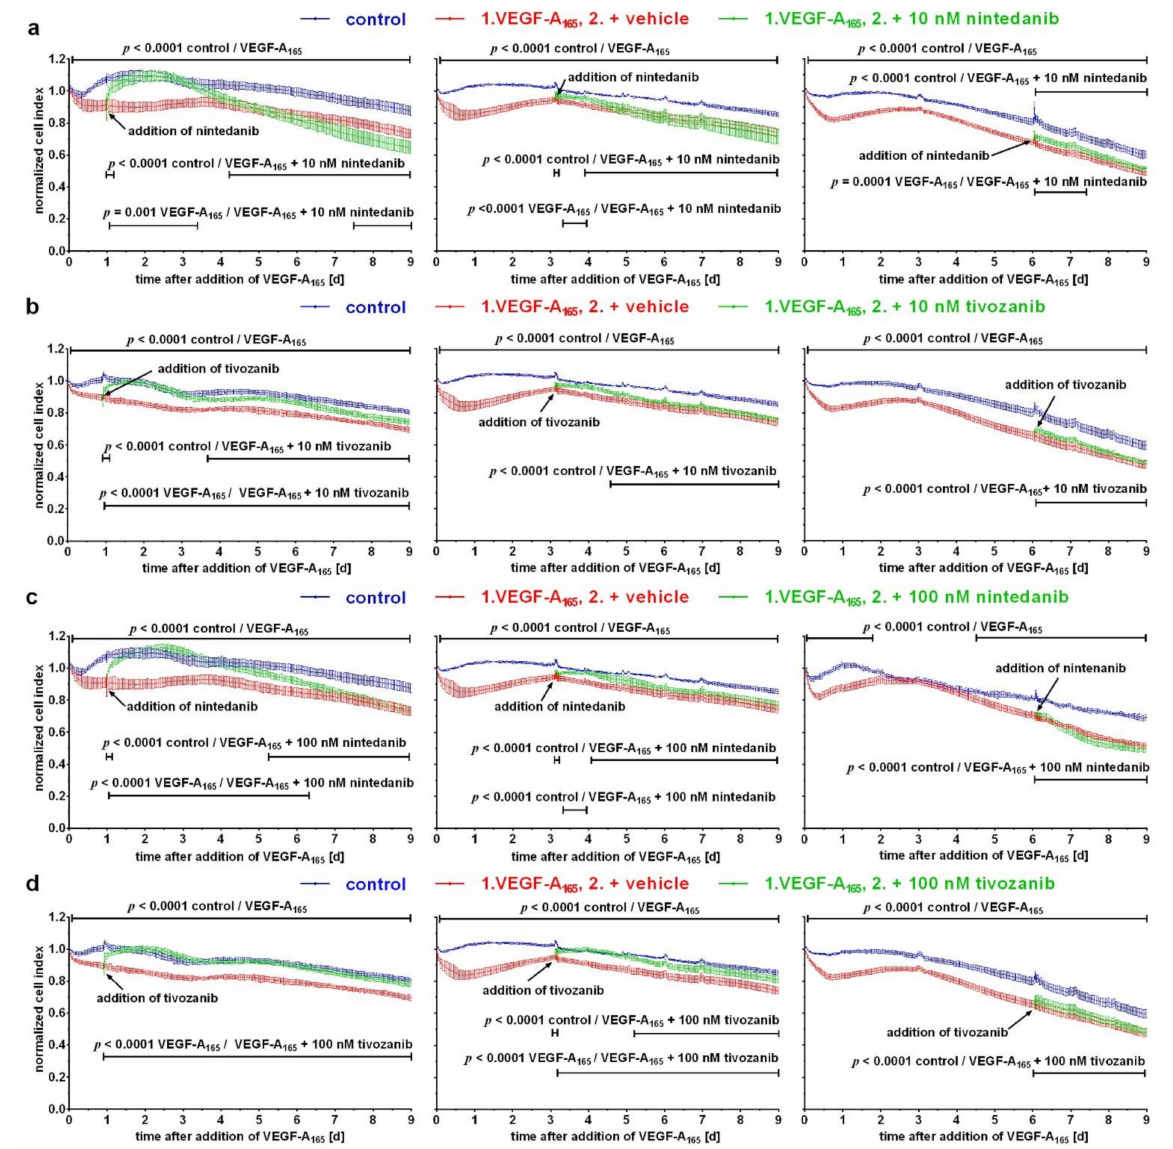
Figure 4. Inhibition of only VEGFR2 was not sufficient to normalize late VEGF-A 165 -induced barrier dysfunction. After exposure of confluent monolayers of iBREC cultivated on gold electrodes to VEGF- A 165 , ( a , b ) 10 nM or ( c , d ) 100 nM, nintedanib or tivozanib were added at indicated time points, and the cell index was measured continuously. Cell index values obtained from more than five wells per condition were normalized to those measured just before the addition of VEGF-A 165 and are shown as means ± standard deviations. ( a , b ) Only when added during the early phase of VEGF-A-exposure were 10 nM nintedanib or tivozanib able to revert the induced changes, although these effects were not long-lasting. ( c , d ) When added during the early phase of VEGF-A-exposure, tivozanib, but not nintedanib, completely and sustainably normalized induced changes. Both inhibitors had little or no effect when added